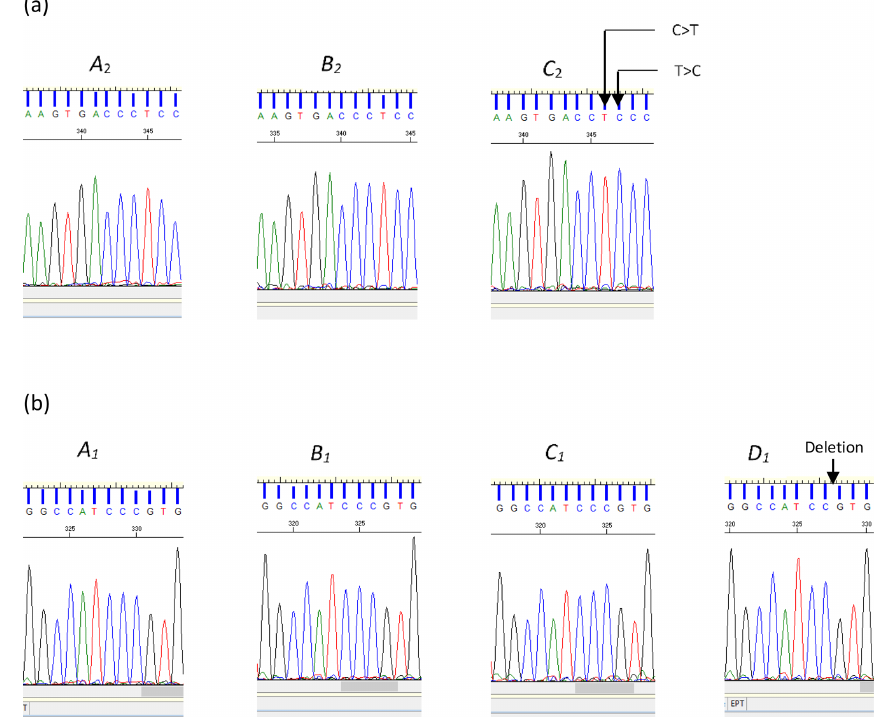
Figure 2. (a) Sequence chromatograms illustrating the differences between variants A 2 and B 2 and variant C 2 of the bovine LEP intron 2 region. The chromatogram of variant C 2 indicates the positions of the two nucleotide substitutions C > T and T > C (nucleotide sequence variation c.144 + 907C/T and c.144 + 908T/C respectively). (b) Chromatograms for A 1 , B 1 , C 1 , and D 1 . The chromatogram of variant D 1 illustrates the position of the deleted cytosine (c.144 +